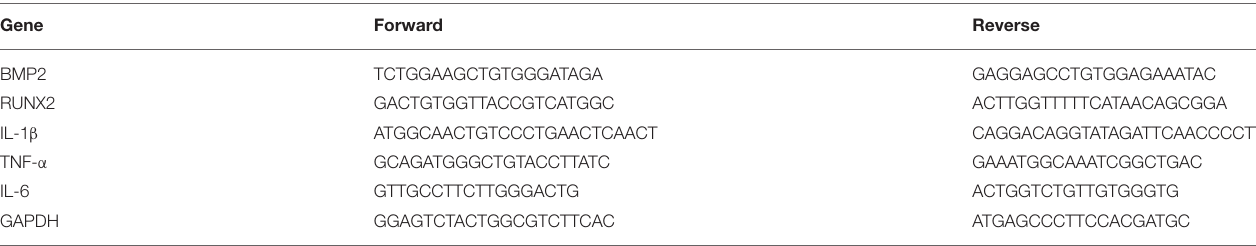
TABLE 1 | qPCR primers used in this study.